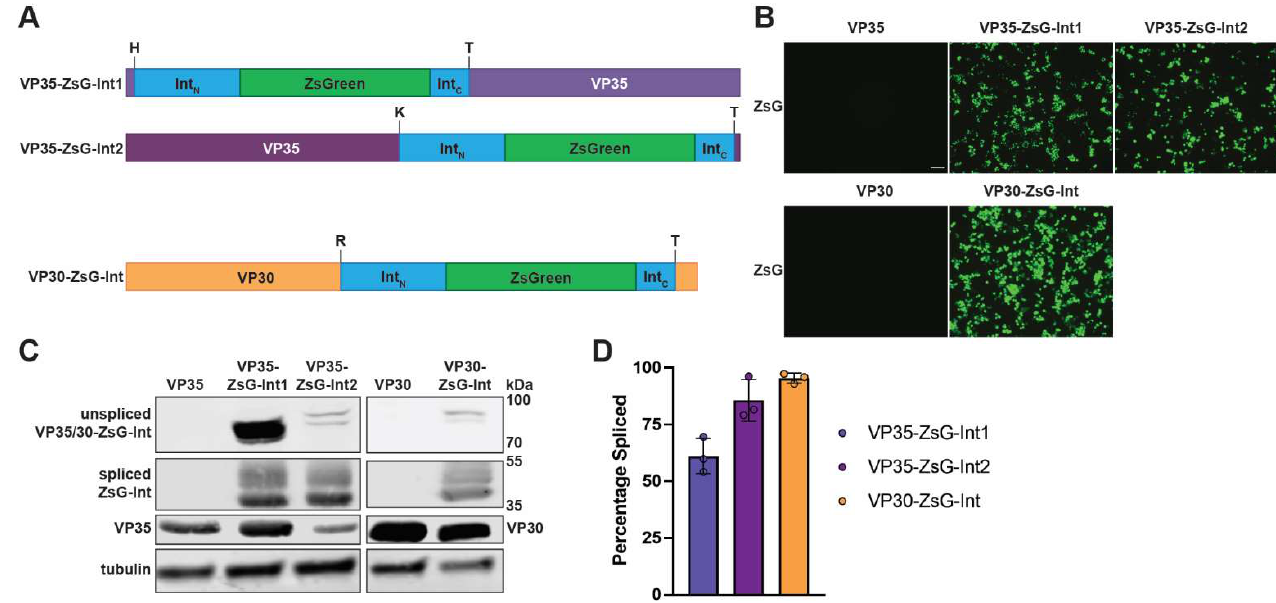
Figure 2. Expression and splicing efficiency of two Ebola virus (EBOV) proteins containing ZsG-Int. ( A ) Diagram of EBOV VP35 and VP30 fusion proteins used in this study. Length is relative to the number of residues and insertion position. Amino acid residues flanking the intein insertion are shown above each diagram. VP35 in purple, VP30 in orange, and remaining coloring as in Figure 1. ( B ) Expression of functional ZsGreen in 293T cells expressing wt and ZsG-Int-containing VP35 and